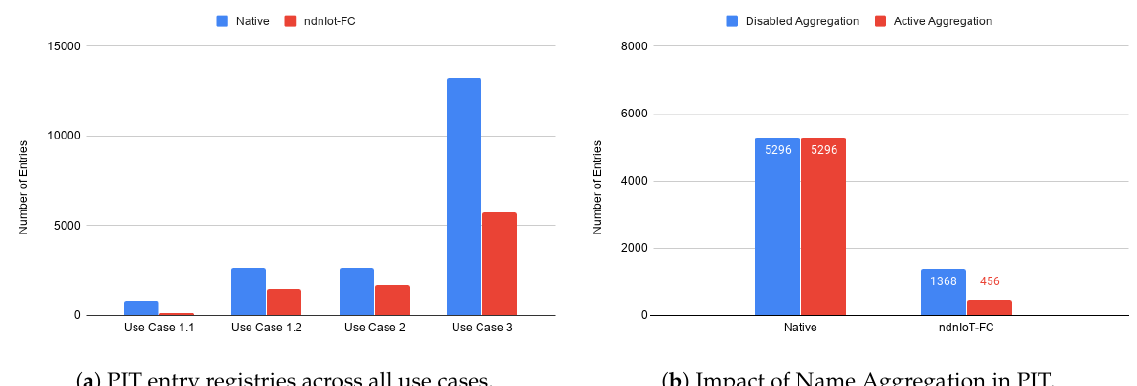
Figure 14. PIT usage